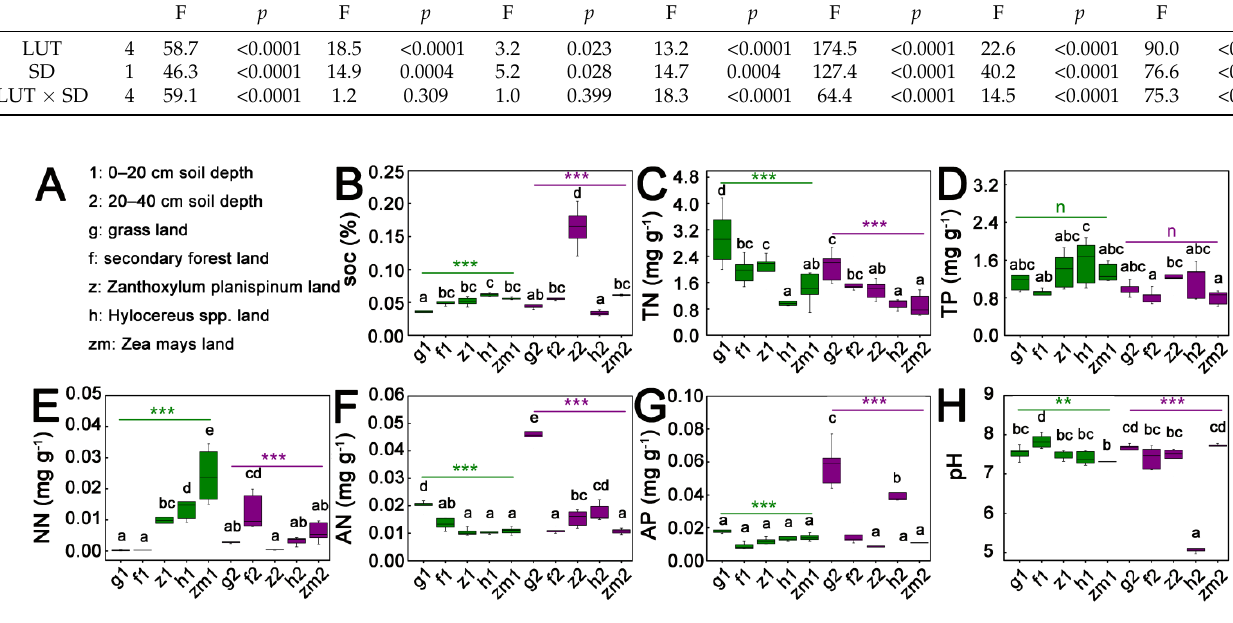
Figure 1. Effect of the different land use types on soil nutrients in 0–20 cm and 20–40 cm soil depth. ( A ) Description of abbreviations, ( B ) SOC content, ( C ) TN content, ( D ) TP content, ( E ) NN content, ( F ) AN content, ( G ) AP content, ( H ) pH. The different letters are significantly different with ANOVA followed by Duncan’s multiple range test at the level of p < 0.05. ** and *** above green line and purple line indicate obvious difference at p < 0.01 and p < 0.001 at 0 – 20 cm and 20 – 40 cm soil depths, respectively.